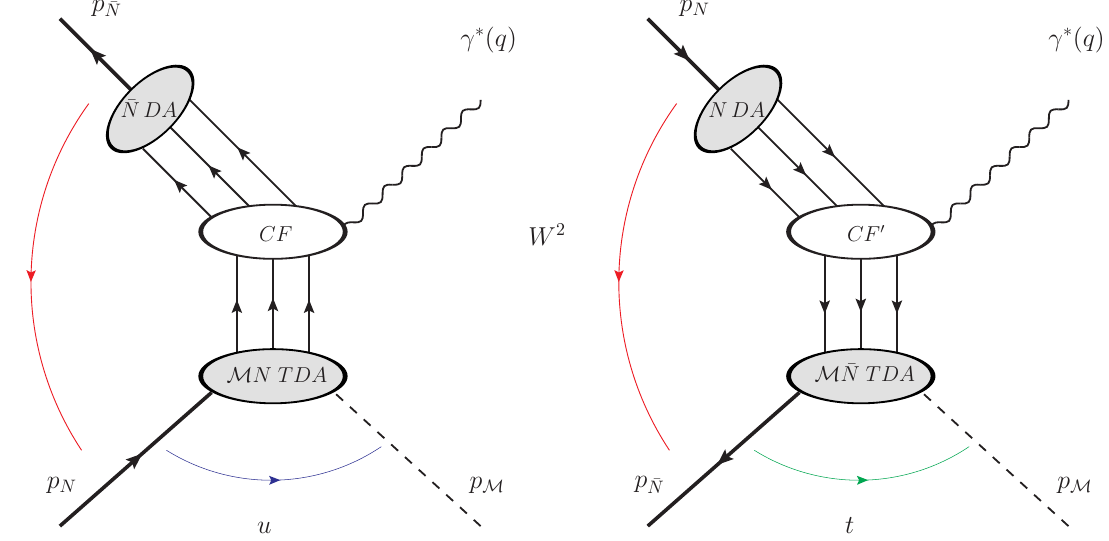
Figure 4. The annihilation process NN γ ∗ M at PANDA detector is sensitive to the TDA factoriza- → tion dynamics in both near-backward ( left ) and near-forward ( right ) kinematics. See text for details. FIG. 1: Two possibilities for collinear factorization of the annihilation process Here, “CF” stands for the perturbatively calculated coefficient function and W 2 = ( p N + p ¯ N ) 2 N ¯ N 0) . Right panel: